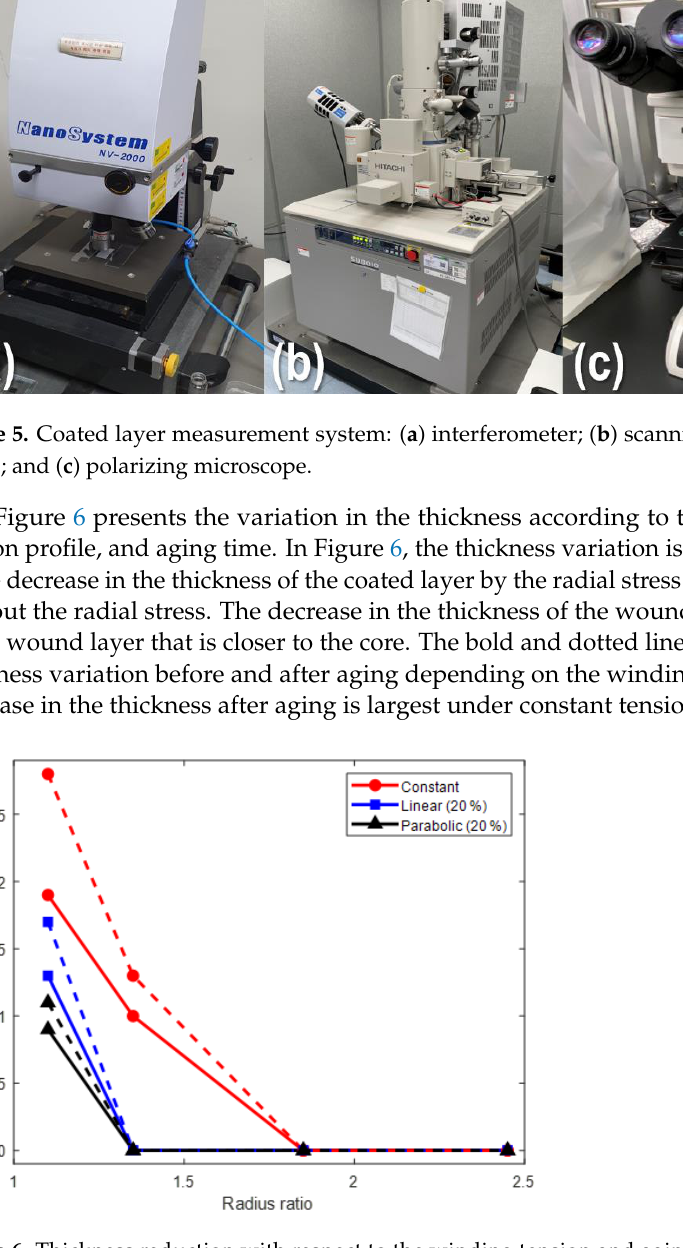
Figure 6. Thickness reduction with respect to the winding tension and aging time.